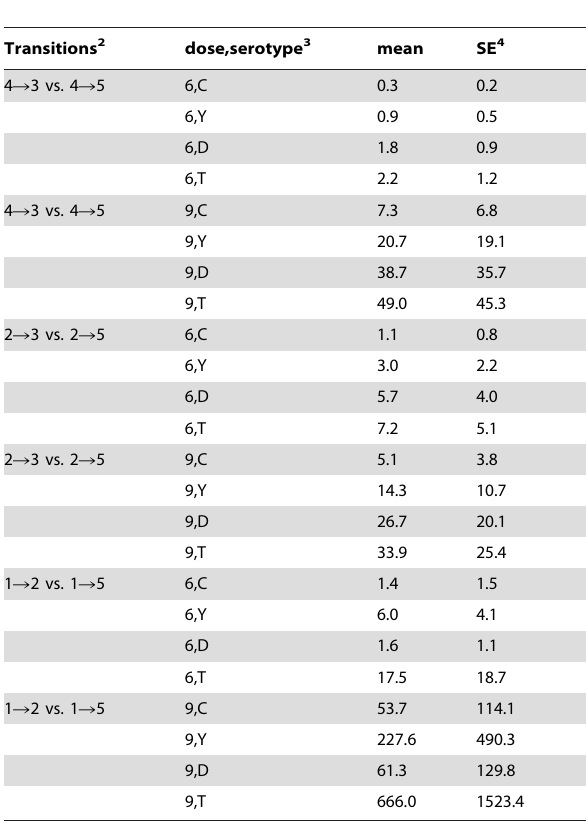
Table 2. Mean sojourn and the expected total times in days for transient states of the fecal shedding model 1